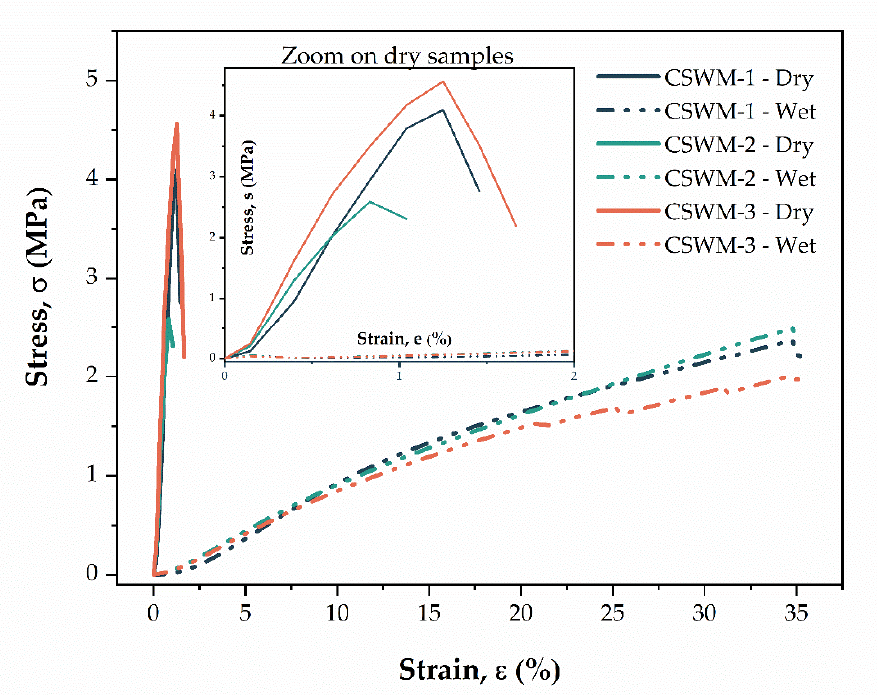
Figure 6. Representative stress–strain curves ( n = 10) of the dry and hydrated of the chitosan woven meshes.